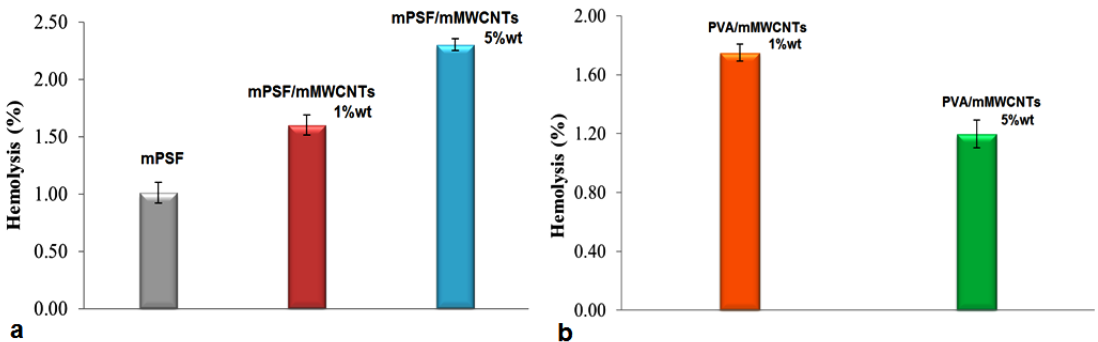
Figure 9. Hemolysis results for samples based on mPSF ( a ) and PVA ( b ).